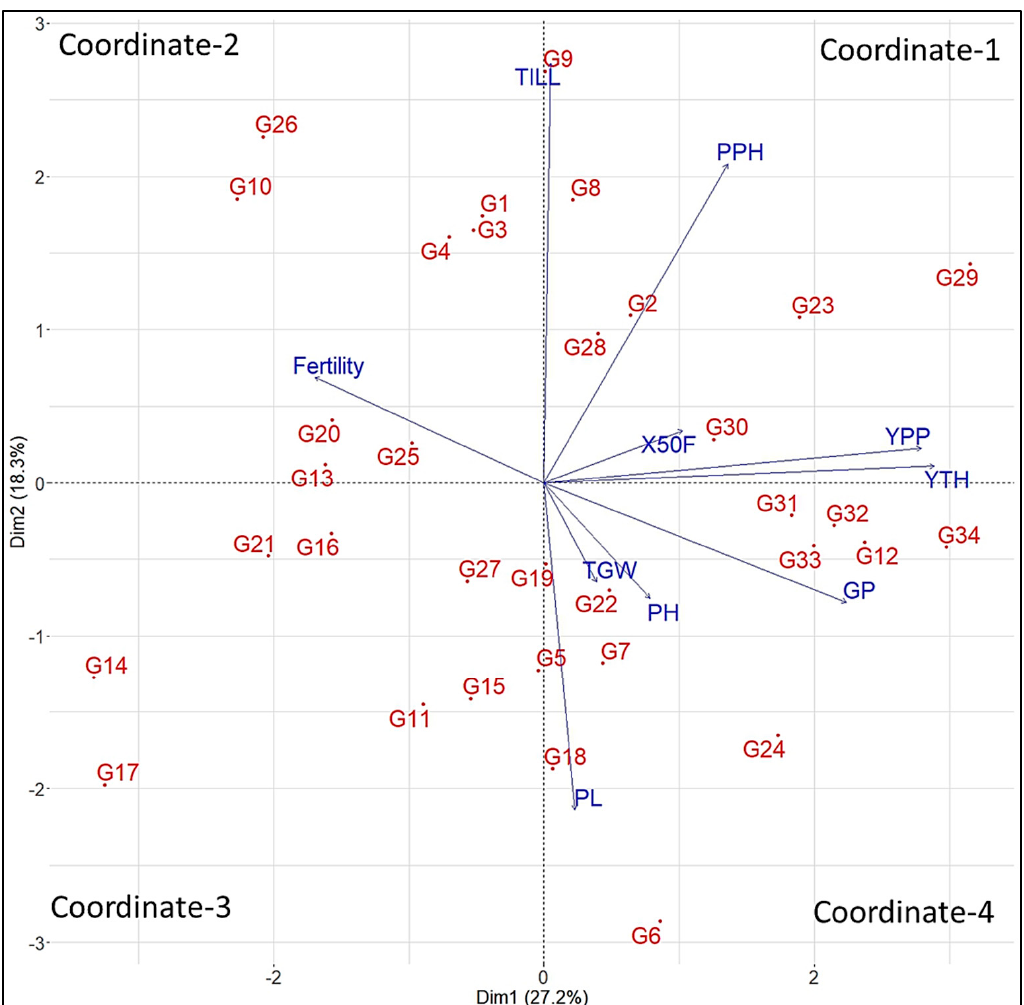
Figure 3. Biplot for the 34 rice genotypes and 10 agronomic traits along the first 2 principal components. Note: X50F = days to 50% flowering, PH = plant height (cm), TILL = number of tillers per hill, PPH = number of panicles per hill, PL = panicle length (cm), GP = grains per panicle, Fertility = fertility (%), YPP = grain yield per plant (gm), TGW = thousand grain weight (gm), and YTH = grain yield (t/ha).